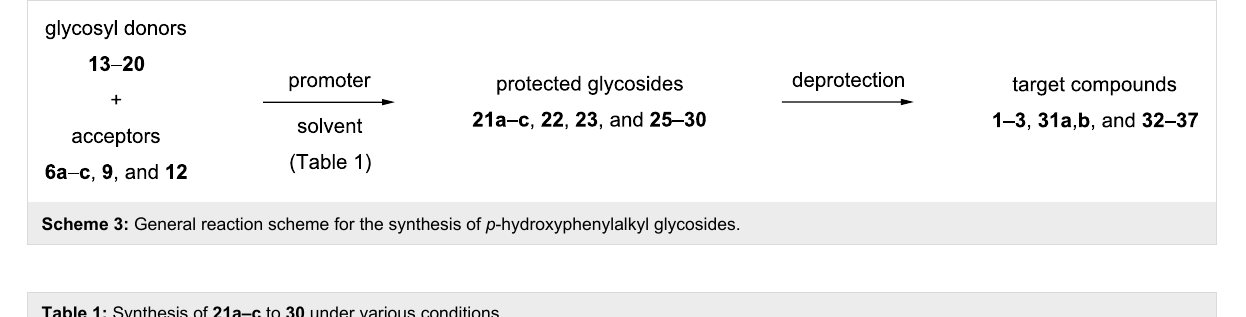
Table 1: Synthesis of 21a–c to 30 under various